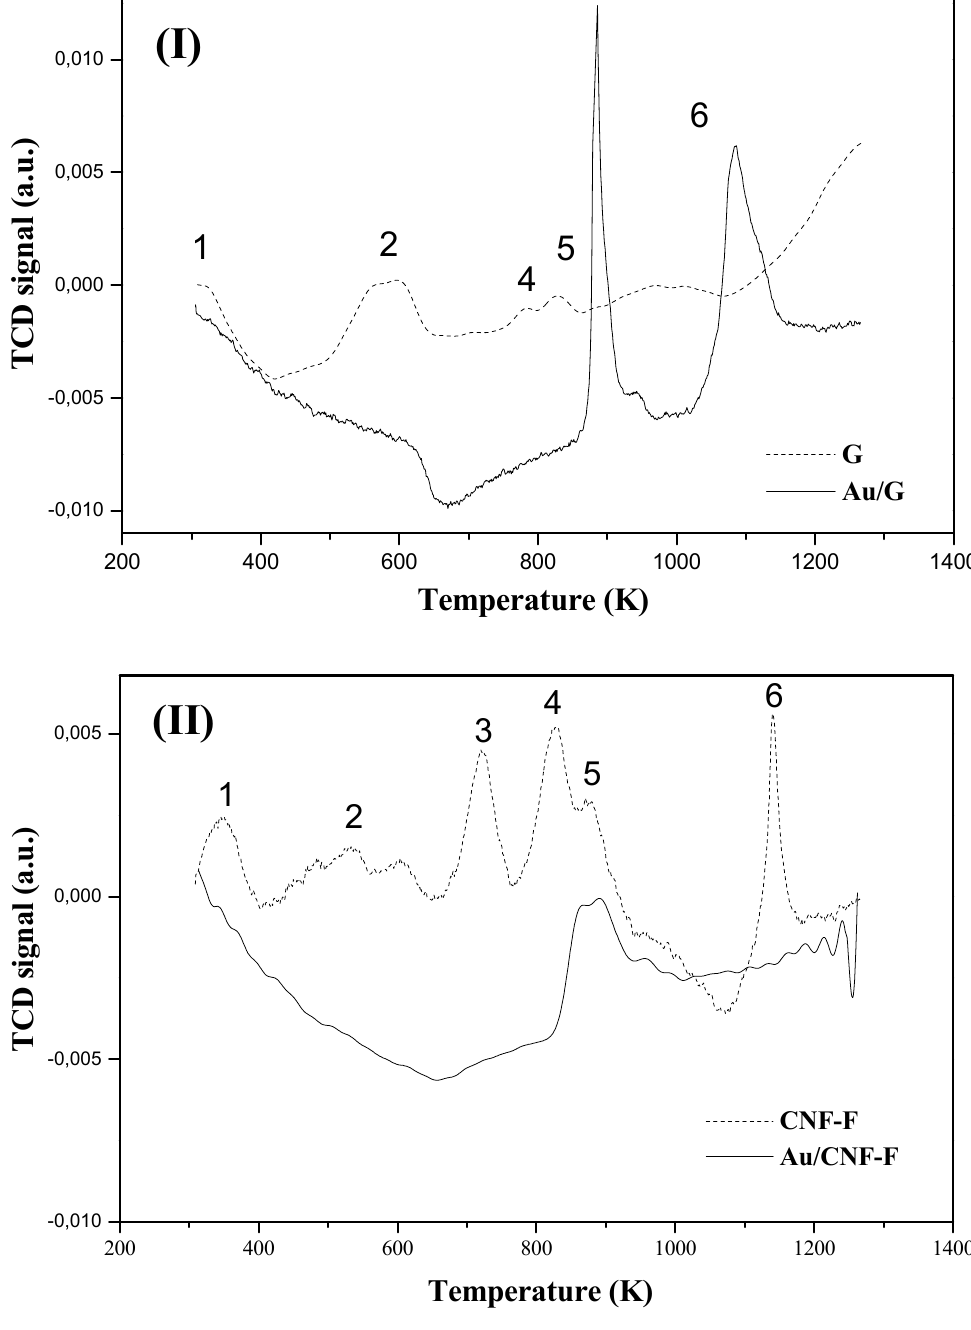
Figure 5. Temperature programmed decomposition profiles associated to samples ( I ) Au/G and ( II ) Au/CNF-F after activation at 873 K (solid line) and the corresponding supports (dashed line), (oxygen groups: 1 and 2 carboxylic groups; 4, anhydride groups; 5, phenol groups; 6, carbonil and quinone